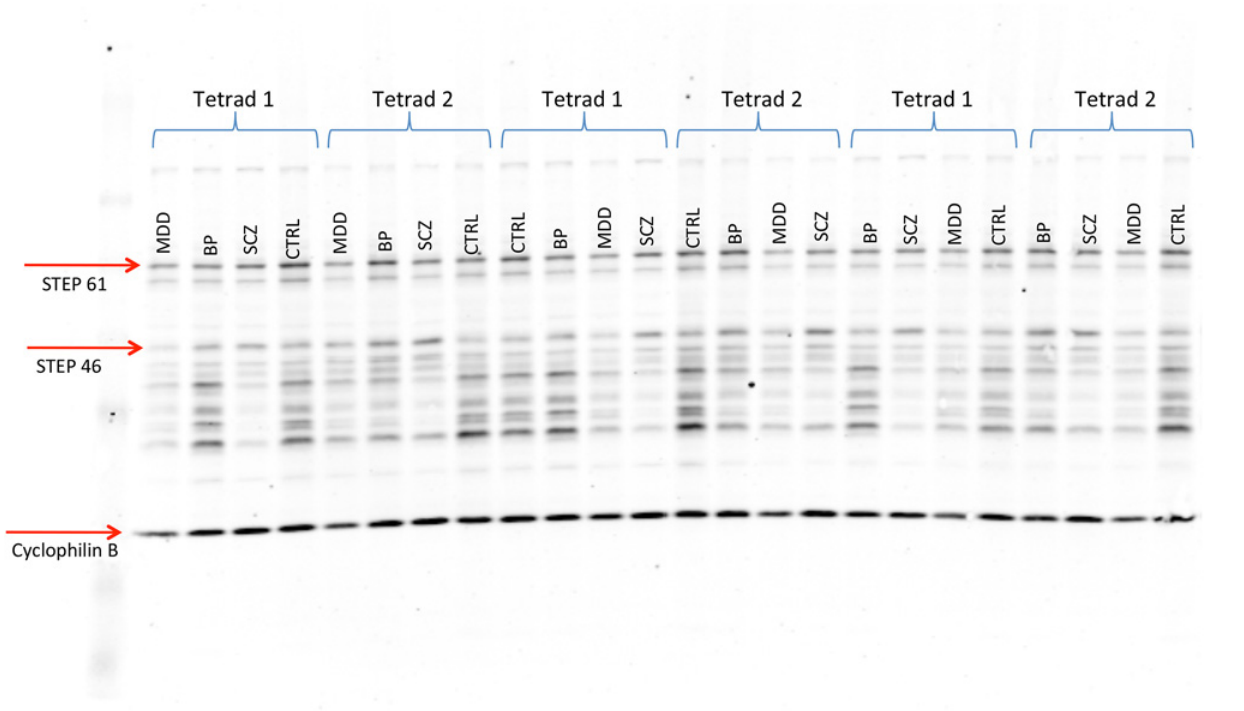
Fig 2. Example western blot from striatal